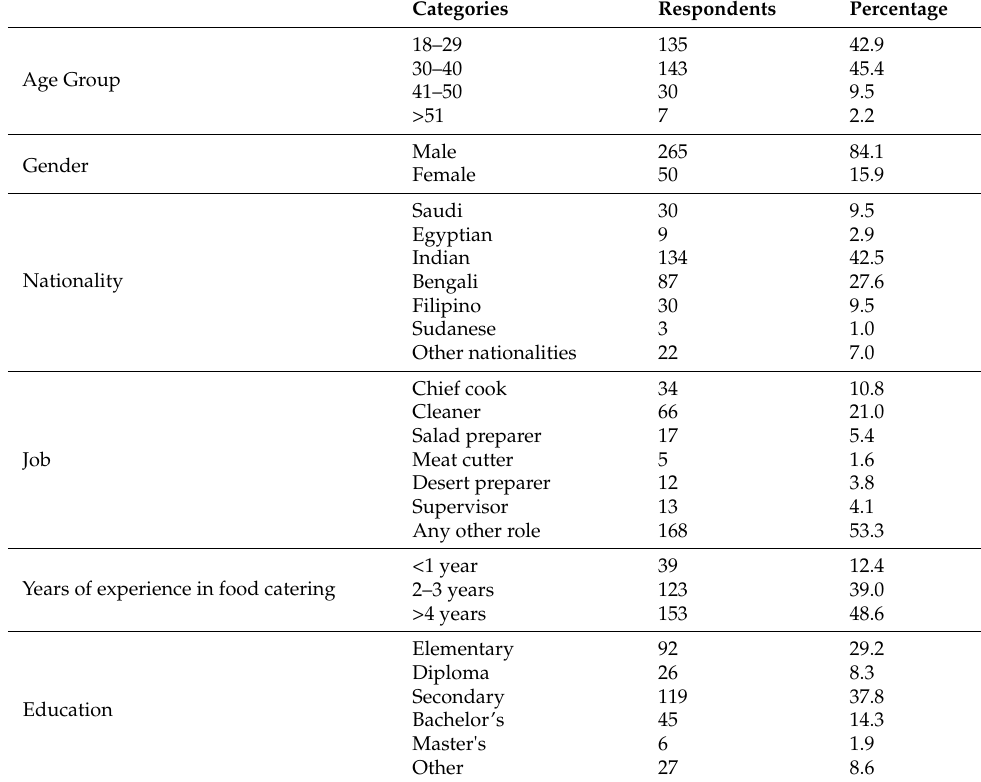
Table 1. The demographic characteristics of food service